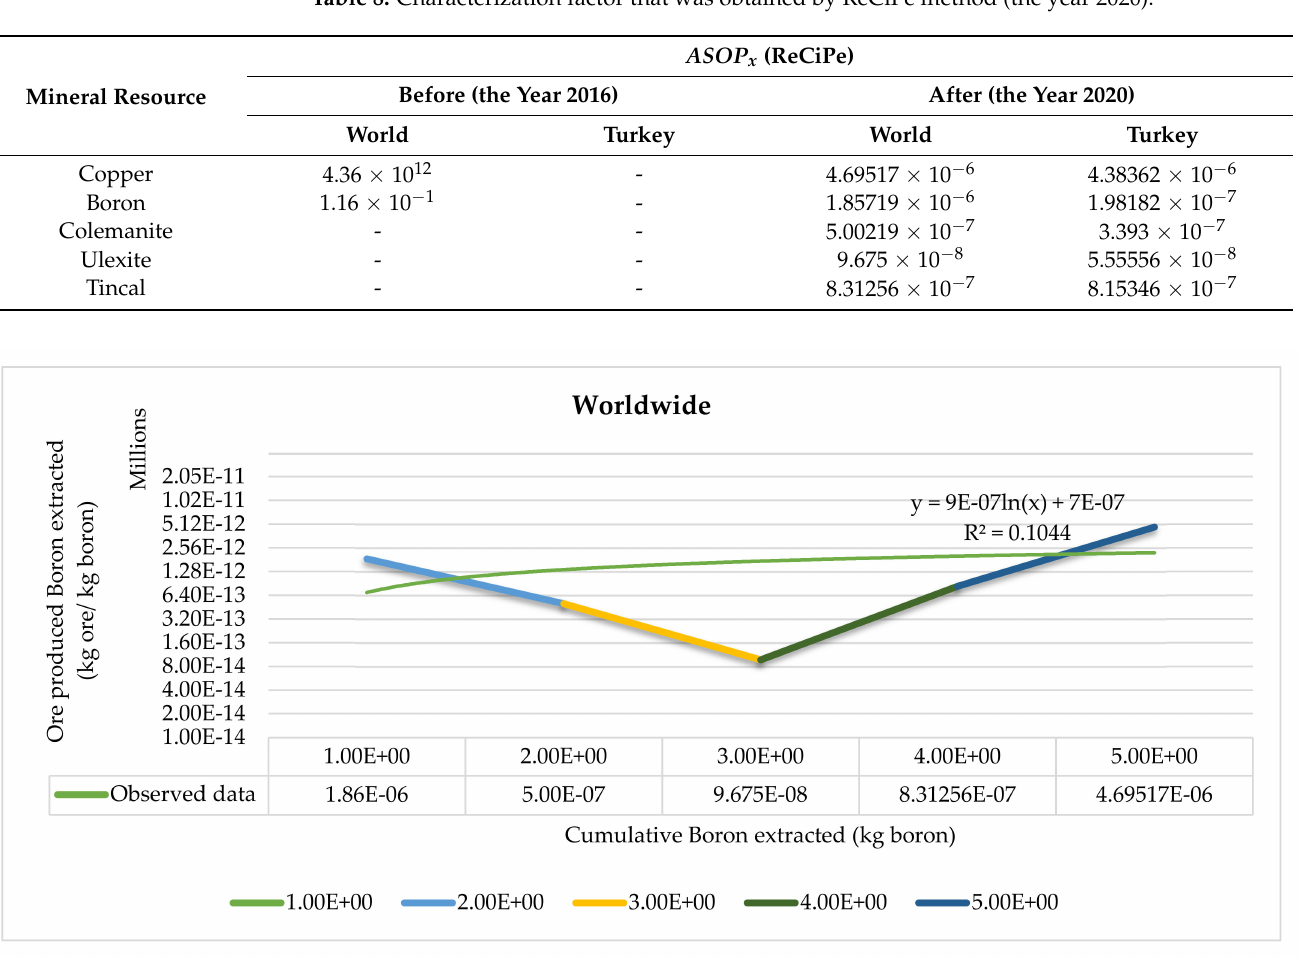
Figure 3. Cumulative grade-tonnage relationship plotted using a log-logistic regression (on a loga- rithmic scale) for existing boron mines (In